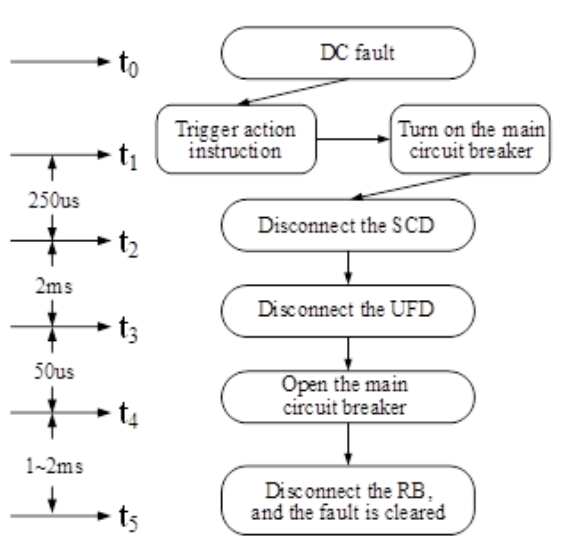
Fig. 3. Timing diagram of fault processing of hybrid DC circuit breaker.